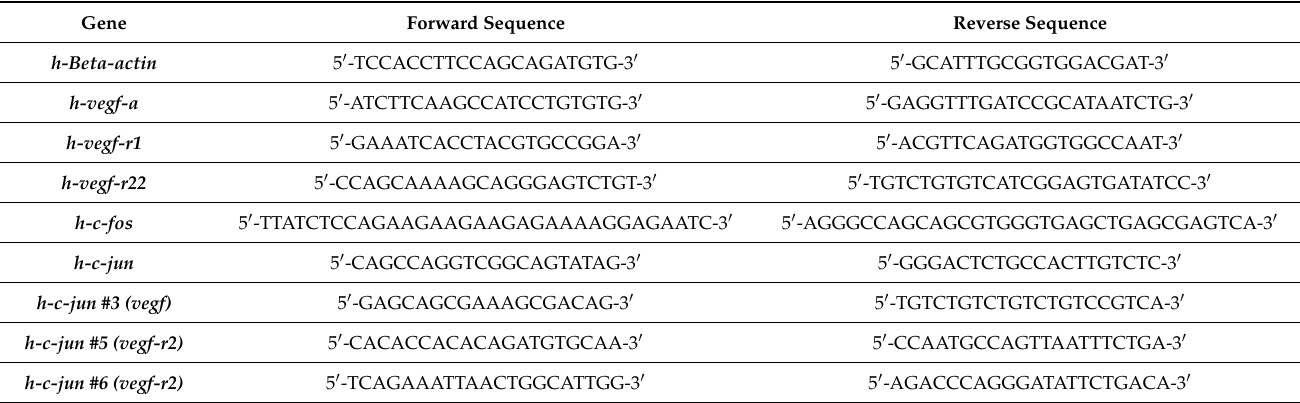
Table 1. Primers used for RT-qPCR